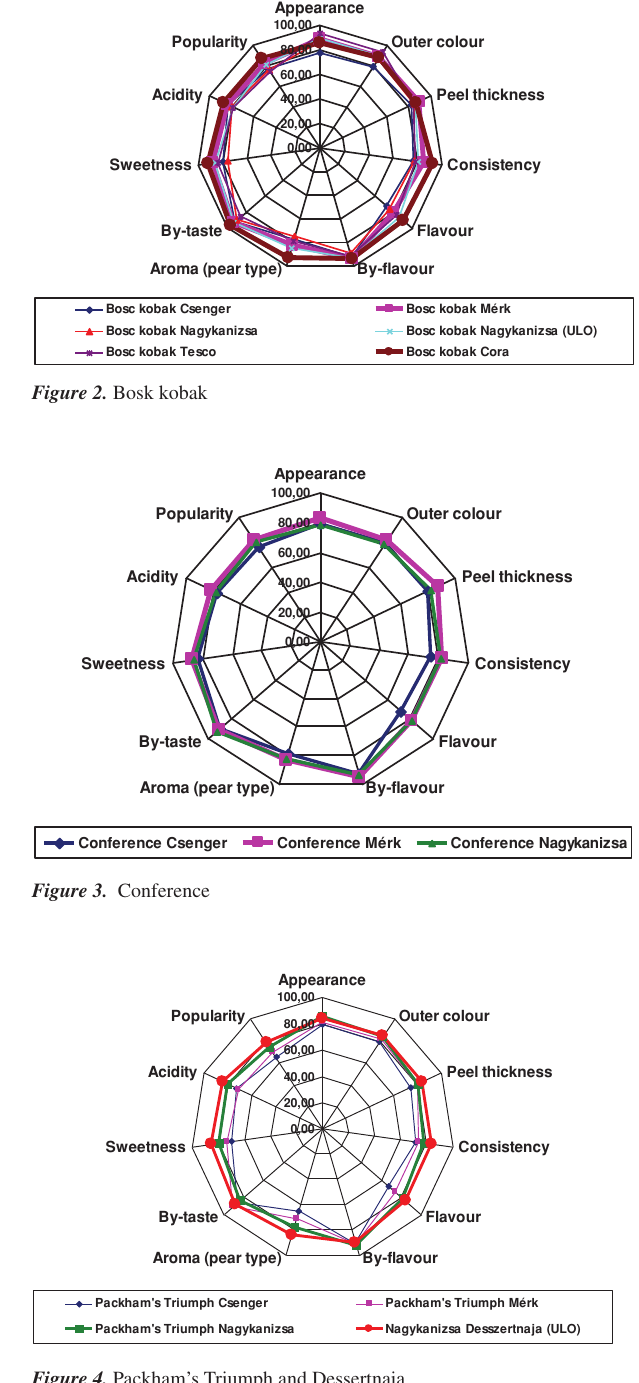
Figure 4. Packham’s Triumph and